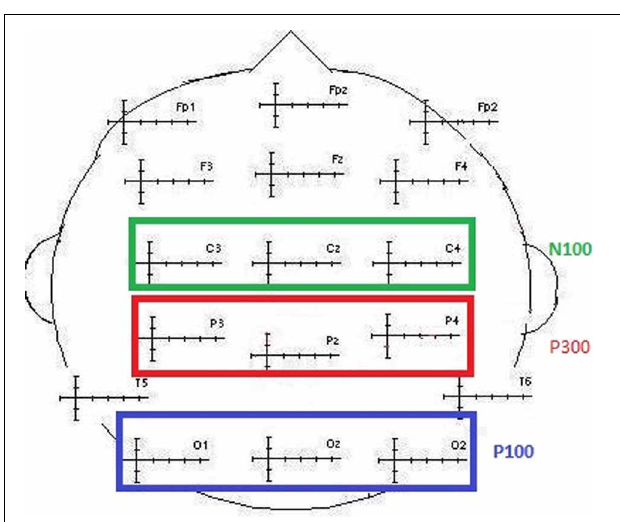
FIGURE 2 | Illustration of the electrodes classically selected to collect N100, P100, and P300 values (amplitude and